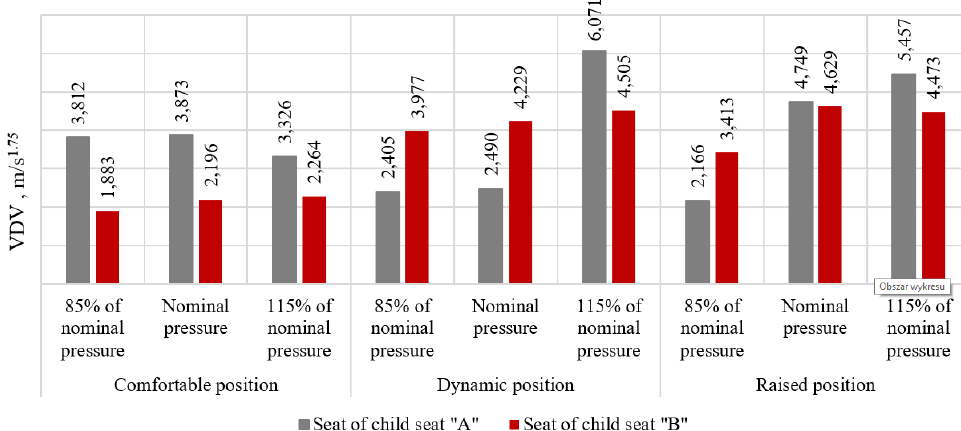
Figure 12: VDV index for the tested seats, loaded with a mass of 5 kg during the tests